Question: Which visualization type does this figure use?
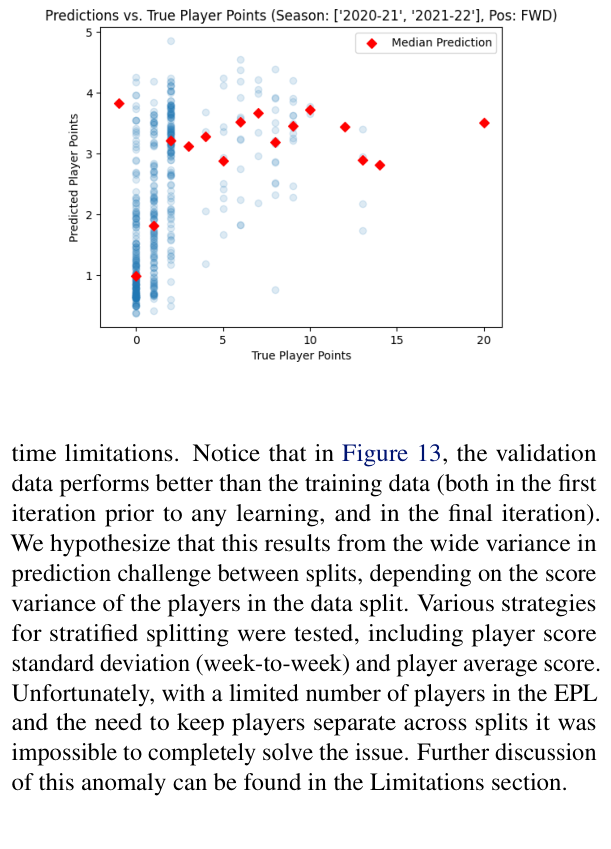
Answer: line